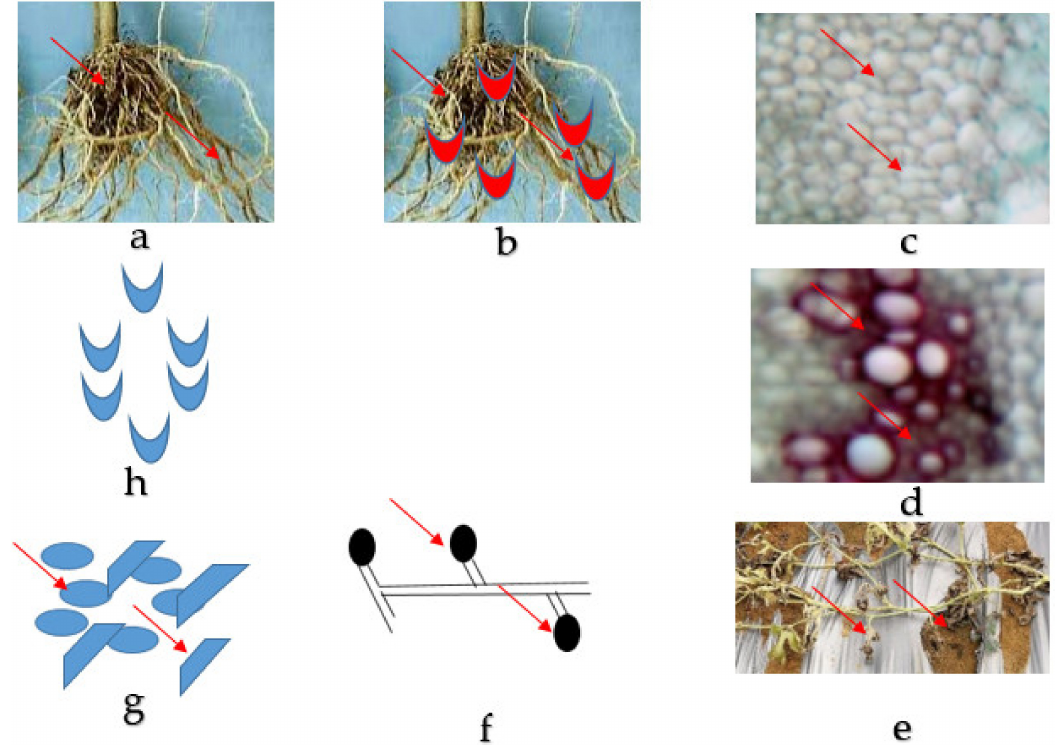
Figure 1. Fusarium wilt disease life cycle of watermelon caused by Fusarium oxysporum f. sp. niveum. ( a ) The healthy root of watermelon. ( b ) Germinating spore in contact with the root for penetration into the tissues. ( c ) Collapsed and distorted vessels in the xylem of the watermelon plant. ( d ) Gum produced by mycelia in the vessels. ( e ) The entire watermelon plant wilts and dies. ( f ) Spore formed by mycelia in the soil. ( g ) Micro and macroconidia present in the soil. ( h ) Germinating